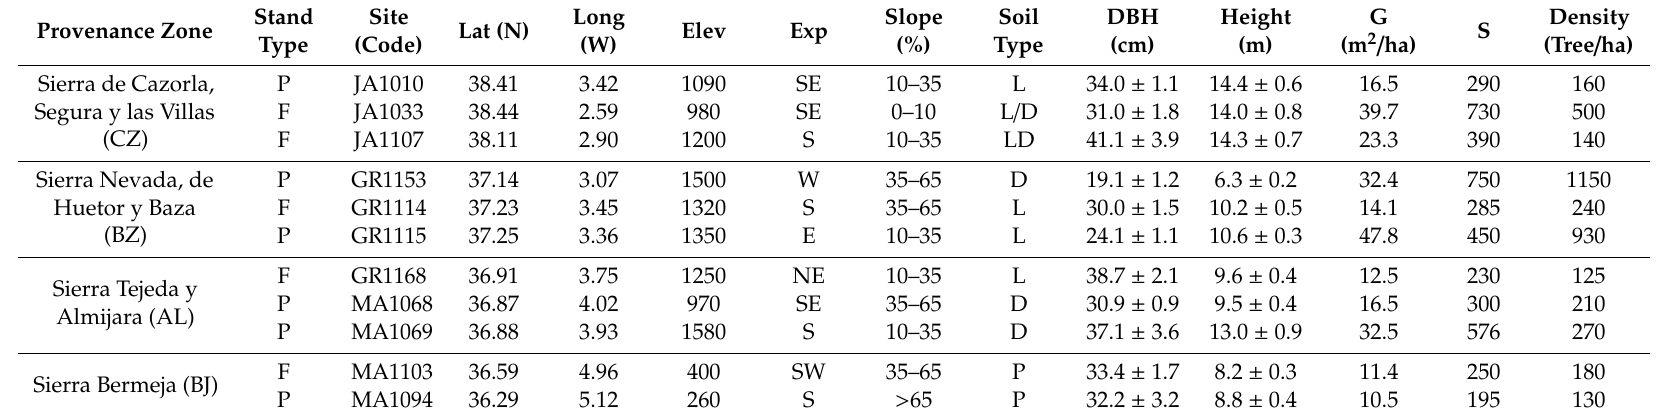
Table 1. Topographical and silvicultural characteristics of the Pinus pinaster forests sampled in Andalusia, ordered from north to south. Values are ranges (slope) or means ± SE. Abbreviations: F, forest (naturally regenerated stands); P, planted stands; Elev, Elevation (m.a.s.l.); Exp, Aspect, L, limestones; D, dolomites; P, peridotites; G, basal area; S, Reineke